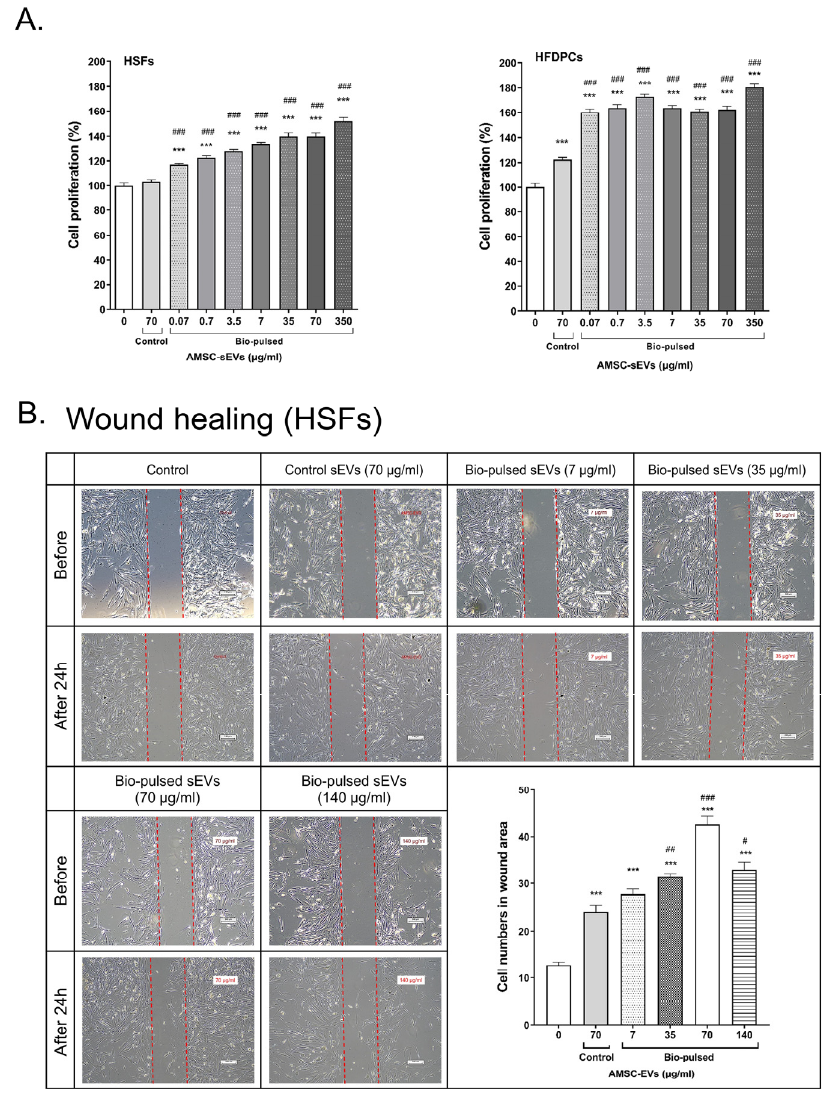
Figure 4. Bio-pulsed avian-derived mesenchymal stem cell (AMSC)-sEVs enhanced cell proliferation and wound healing. ( A ) The cell proliferation of human skin fibroblasts (HSFs) and human follicle dermal papilla cells was significantly augmented after treatment with bio-pulsed AMSC-sEVs for 4 days. (n = 12, data are expressed as the mean ± standard deviation; *** p < 0.001, compared with the 0 μ g/mL group; # p < 0.05, ## p < 0.01, ### p < 0.001, compared with the control AMSC-sEV group). ( B ) Bio-pulsed AMSC-sEVs enhanced wound healing compared with control AMSC-sEVs in HSFs after treatment for 24 h. (n = 4, data are expressed as the mean ± standard deviation; *** p < 0.001, ### p < 0.001, compared with the control AMSC-sEVs group).